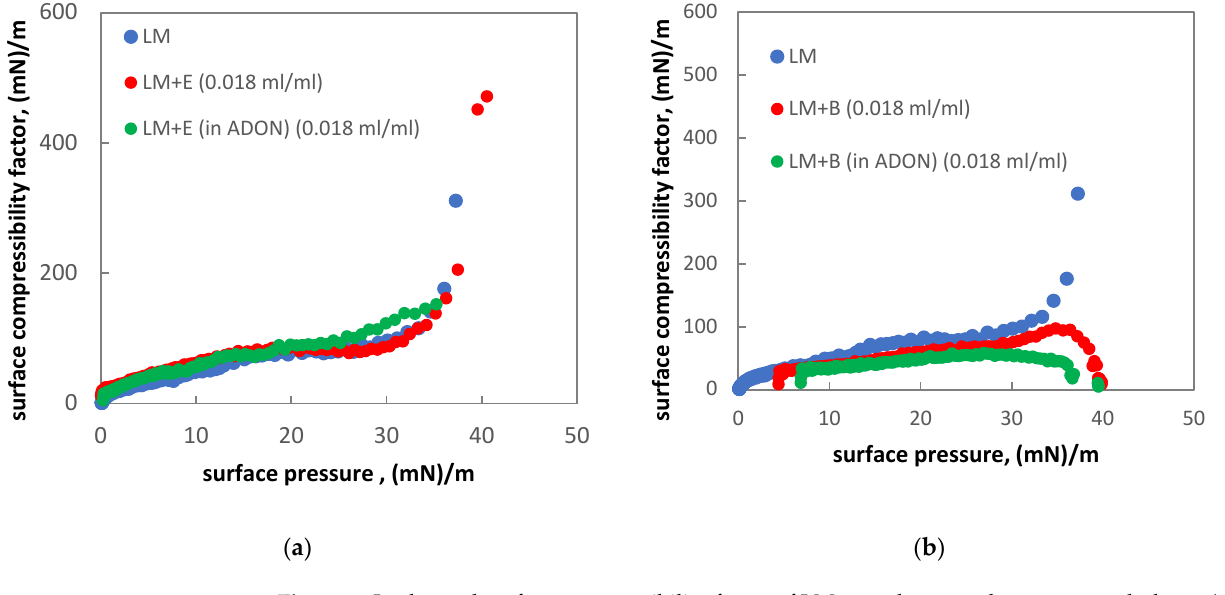
Figure 4. Isothermal surface compressibility factor of LM monolayer on the aqueous subphase: ( a ) in the presence of ectoine pharmaceutical solution (E) diluted with water or ADON, ( b ) in the presence of pharmaceutical drug with budesonide (B) diluted with water or ADON.